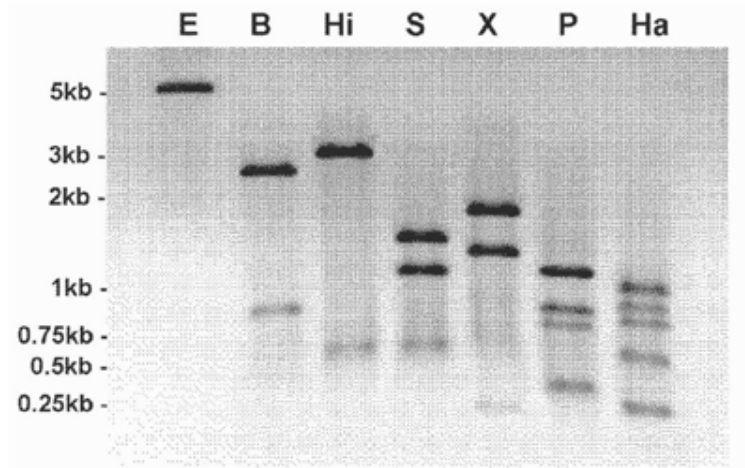
Figure 3. RFLP profiles of genomic DNA. Complete Dh PG sequence as a probe (PCR product with PREPF-EPR). E, Eco Ri; b, Bam Hi; Hi, Hind iii; S, Sca I; X, Xba i; P, Pvu ii; Ha, Hae